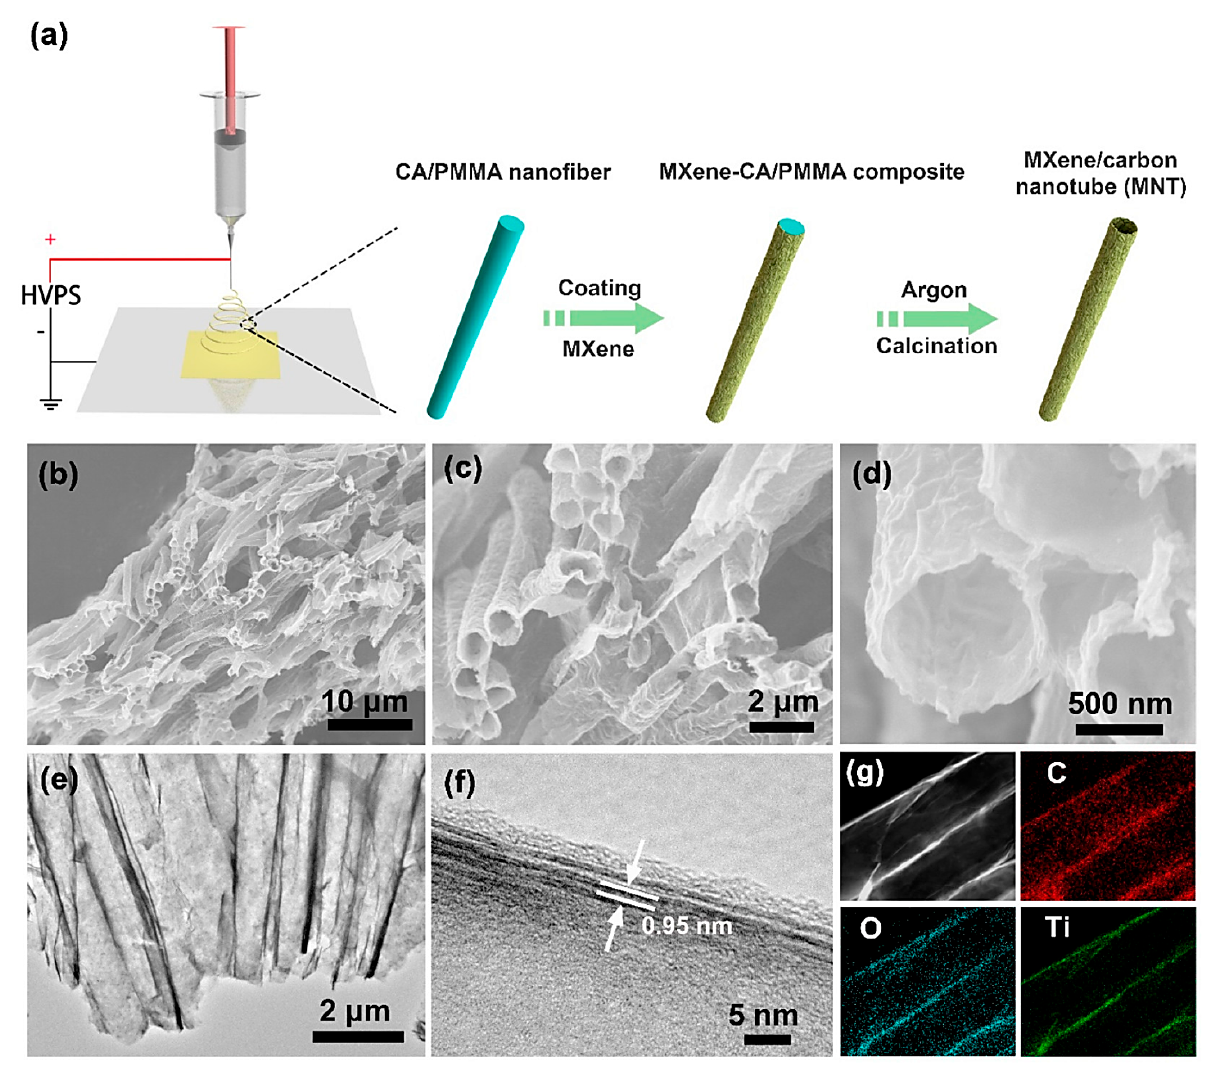
Figure 7. ( a ) The preparative process of MXene/CNT composites, with ( b – d ) SEM images and ( e,f ) high resolution transmission electron microscopy (HR-TEM) images. ( g ) The elemental mapping demonstrating the carbon (C), oxygen (O), and titanium (Ti) distributions of the composite. Adapted from Ref [110] with permission. Copyright 2021 American Chemical Society.